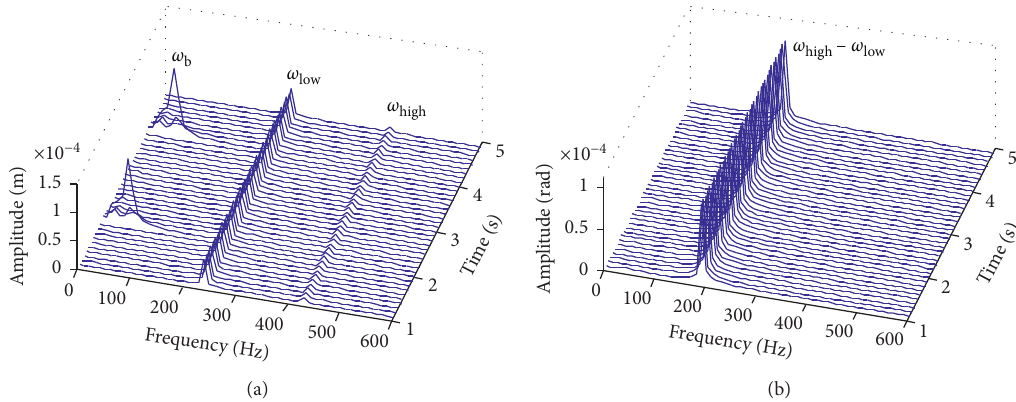
Figure 9: Transient time-frequency waterfall curves of the bending and torsional motions of the rotor system without the rub-impact fault. (a) Bending motion and (b) torsional motion.